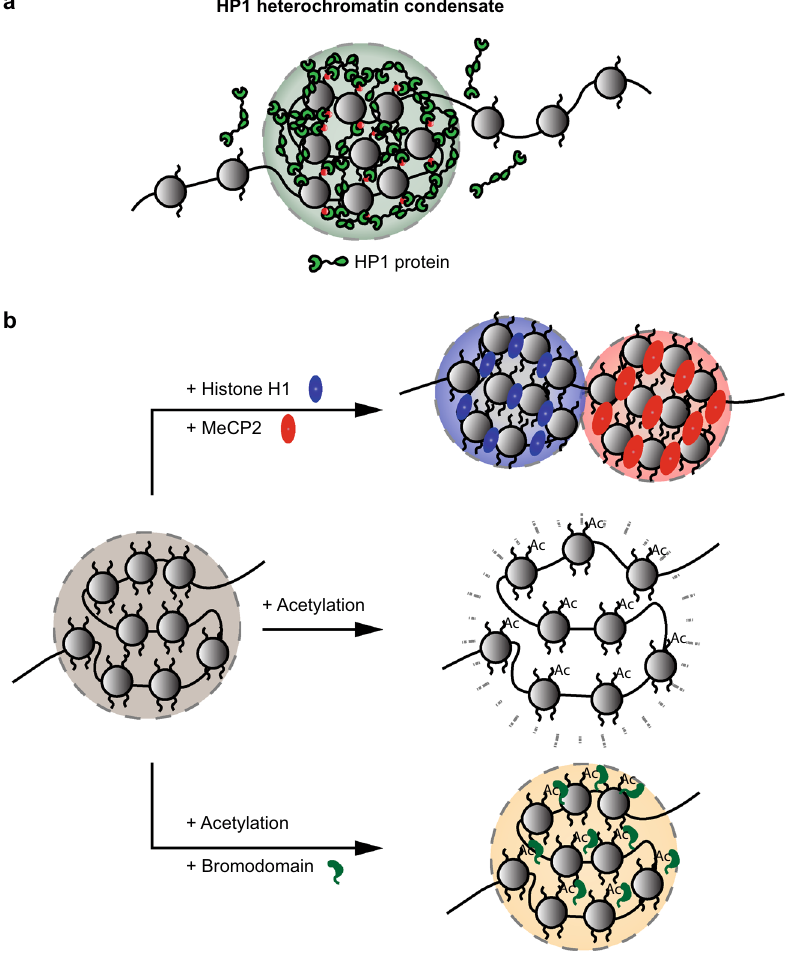
Fig. 1 LLPS in heterochromatin and genome organization. a HP1 proteins associate with H3K9Me3 marks (red), oligomerize, and mediate the LLPS of heterochromatin. b Factors controlling the LLPS of nucleosome arrays. Biomolecular condensates formed by chromatin are modulated by several factors. Addition of the linker histone H1 (blue) and MeCP2 (red) proteins results in the formation of distinct and immiscible condensates. Acetylation of histone tails leads to the dissolution of the condensate, resulting in a more dispersed arrangement of the nucleosomes. Chromatin condensates can be reassembled upon the addition of bromodomain-containing proteins